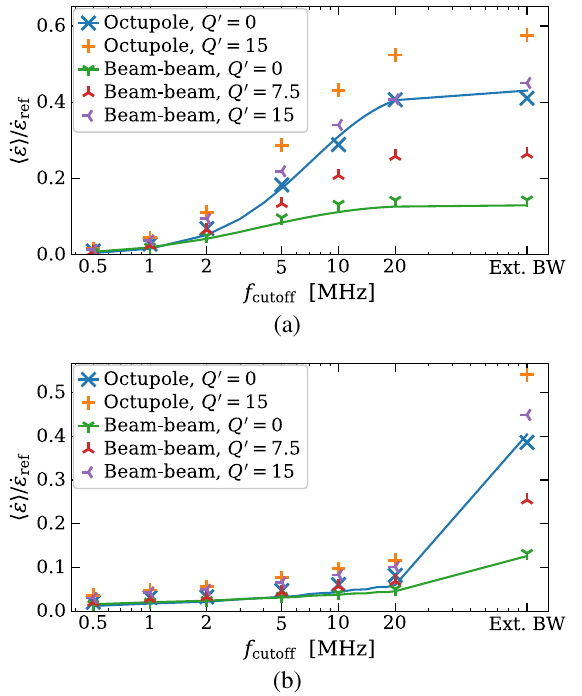
FIG. 5. Average emittance growth for 128 neighboring bunches affected by LF noise, using the EXP filter in (a) and the ADT filter in (b). The solid lines are the expected emittance growth rates, calculated with Eq. (11) and either Eq. (17) for octupole detuning or Eq. (18) for beam-beam interactions.